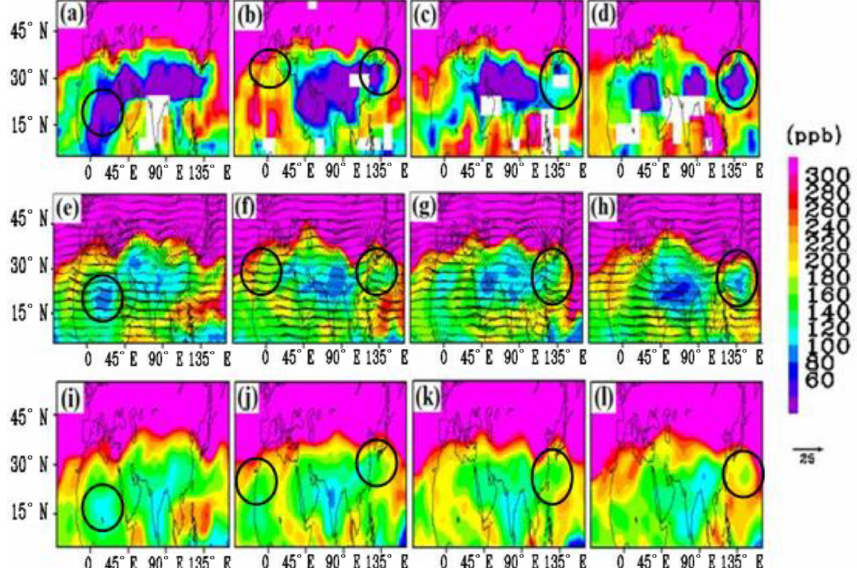
Figure 4. Spatial distribution of ozone mixing ratios (ppb) (colour shades) corresponding to MIPAS satellite observations at 16km for (a) 1– 2 July, (b) 3–4 July, (c) 5–6 July, (d) 7–8 July 2003; ERA-Interim reanalysis at 100hPa for (e) 2 July, (f) 4 July, (g) 6 July and (h) 8 July 2003, and ECHAM5-HAMMOZ CTRL simulations at 16km for (i) 2 July, (j) 4 July, (k) 6 July and (l) 8 July 2003. Black arrows in panels (e) – (h) show wind anomalies (ms − 1 ) at 200hPa. Minimum amounts of ozone near the location of eddies are shown with black circles.